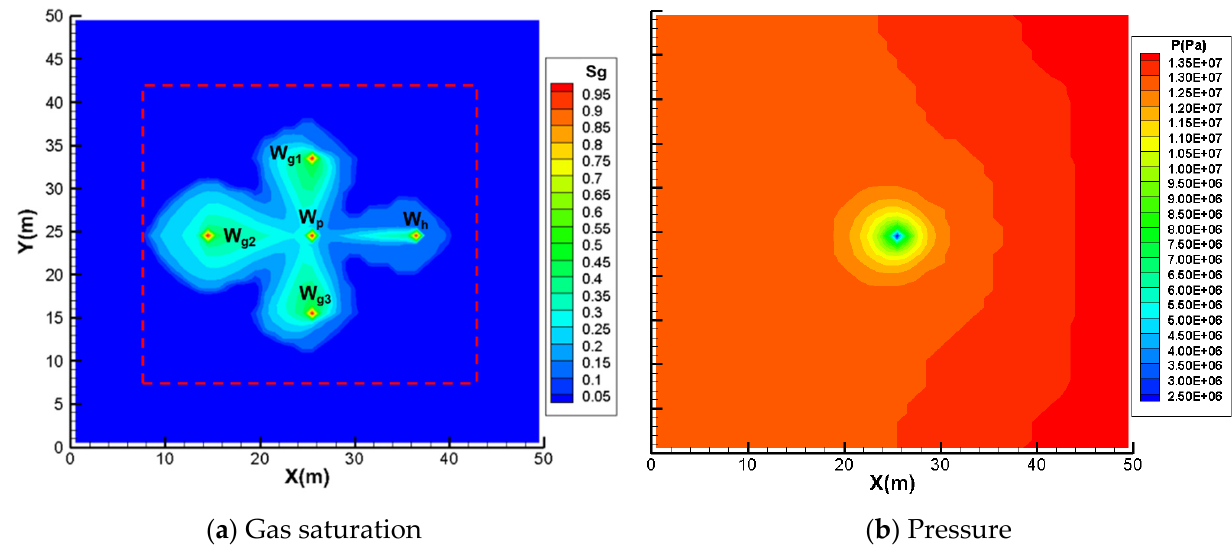
Figure 5. Gas saturation and pressure nephograms after gas injection for 6 months.